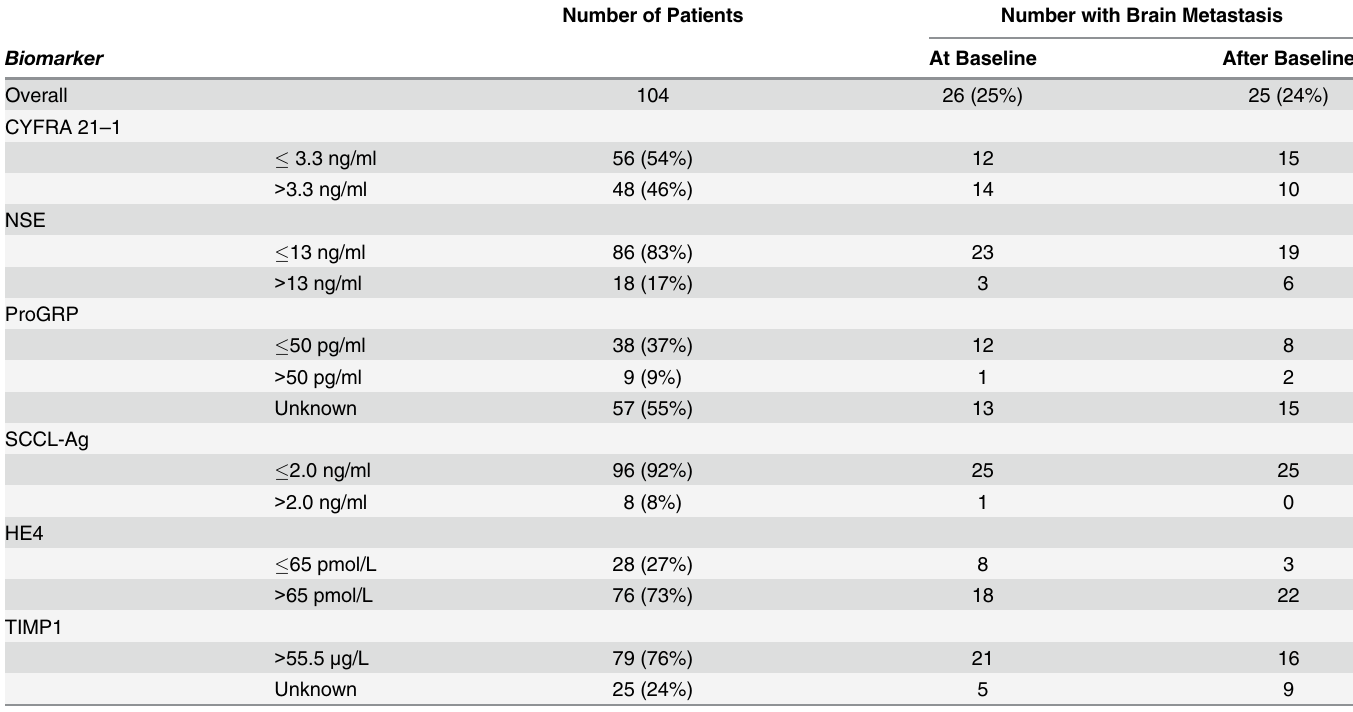
Table 2. Distribution of serum biomarkers and other factors by presence of brain metastases at baseline or development of subsequent brain metastases after baseline. Number of